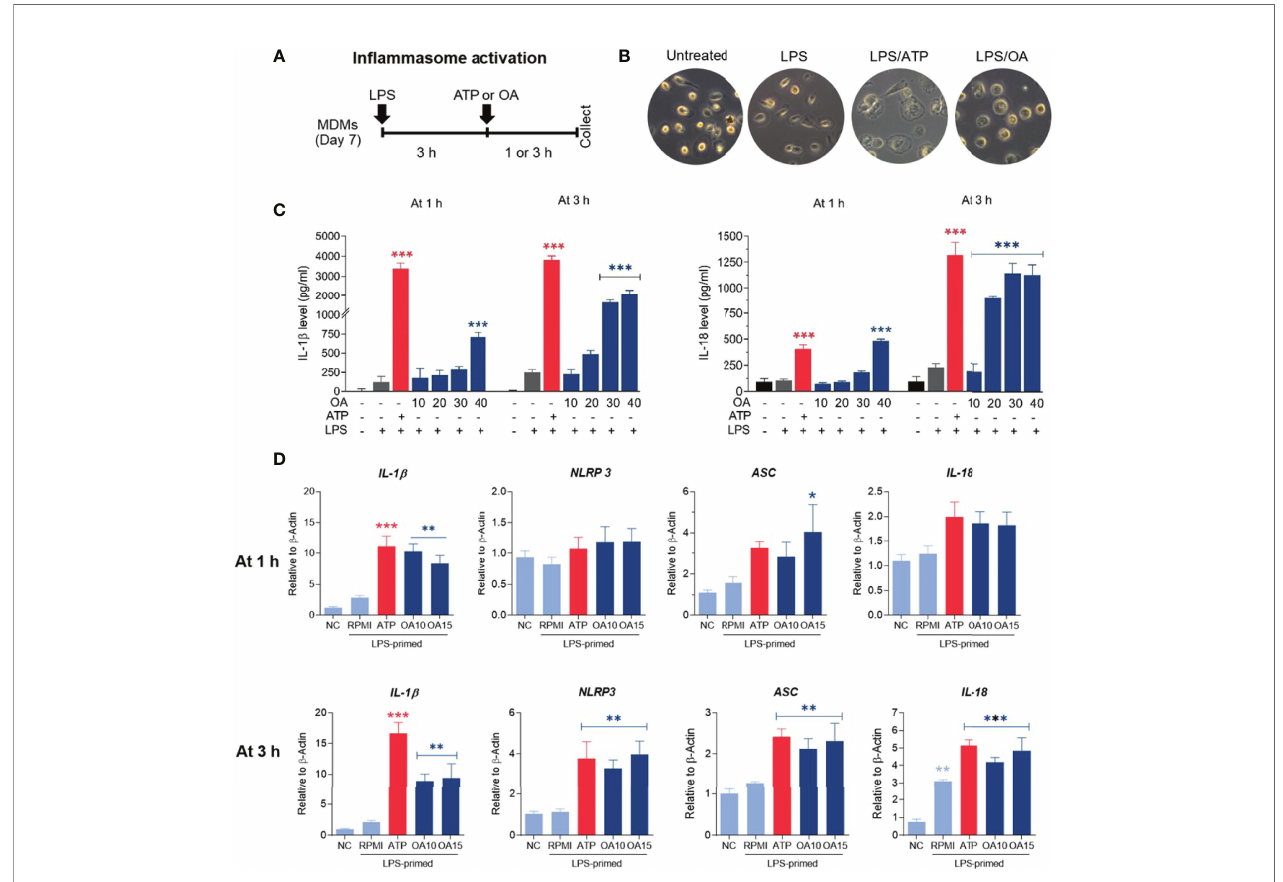
FIGURE 4 | Oleamide mediated in fl ammasome activation and IL-1 b and IL-18 production in LPS-primed MDMs. (A) Scheme of in fl ammasome activation. (B) Cell morphology by invested microscope. (C) IL-1 b and IL-18 levels by ELISA. (D) In fl ammasome-related gene expression by qRT-PCR. MDMs were primed with LPS (100 ng/ml) for 3 h followed by oleamide (OA) (15 µg/ml) or ATP (30 mM) for 1-3 h in all experiments. Data represents the mean ± SEM of three independent experiments (*p < 0.05, **p < 0.01, ***p < 0.001). NC, negative control; LPS, lipopolysaccharides; ATP, adenosine triphosphate; OA, oleamide; ASC, apoptosis- associated speck-like protein containing a C-terminal caspase recruitment domain; NLRP3, NOD-, LRR- and pyrin domain-containing protein